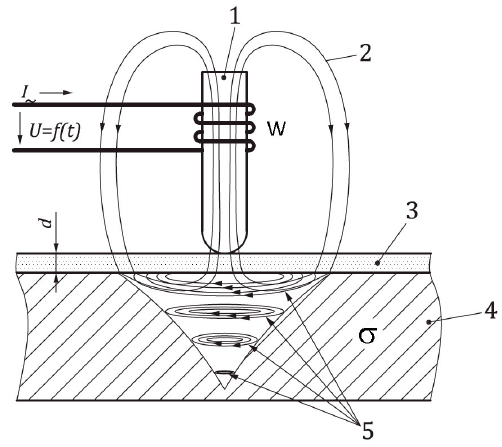
Figure 1. Amplitude-sensitive eddy-current method of measurement of the thickness of coating. 1— probe core with coil W, 2—high frequency magnetic field, 3—non-conductive coating, 4—non-mag- netic electrically conductive base metals, 5—induced eddy current, I —exciting current, U —signal of eddy-current converter.